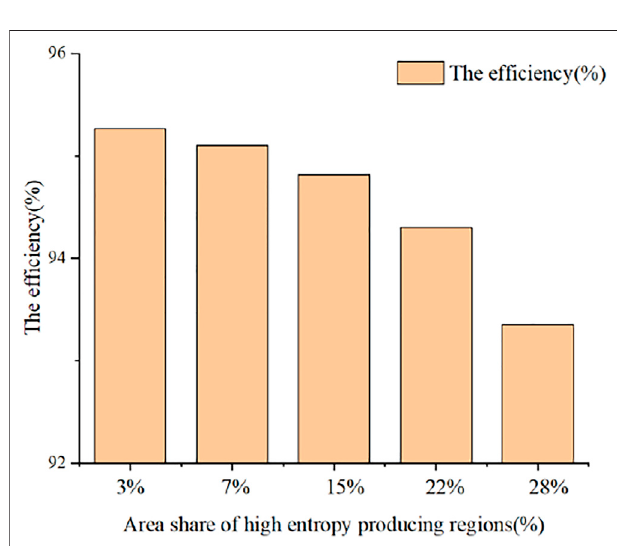
FIGURE 12 | Relationship between the area share of the high-entropy production area and the ef fi ciency of the hydraulic turbine.